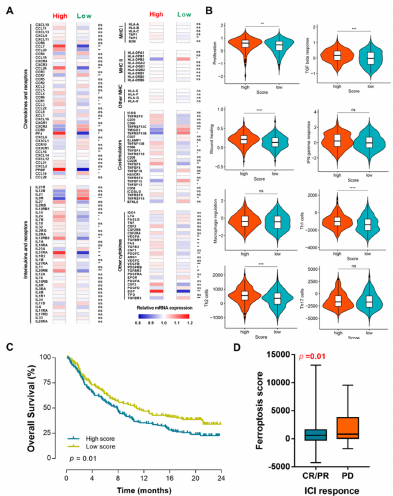
( B ) Cox regression analysis of machine-learning-based ferroptosis score in different types of malignan- cies in the TCGA dataset. ( C ) Gene set enrichment analysis of patients with high ferroptosis scores. ( D , E ) Correlation analyses of ferroptosis scores and different adaptive immune cells ( D )/innate immune cells ( E ) in the TCGA cohort. BCa, bladder cancer; TCGA, The Cancer Genome Atlas.